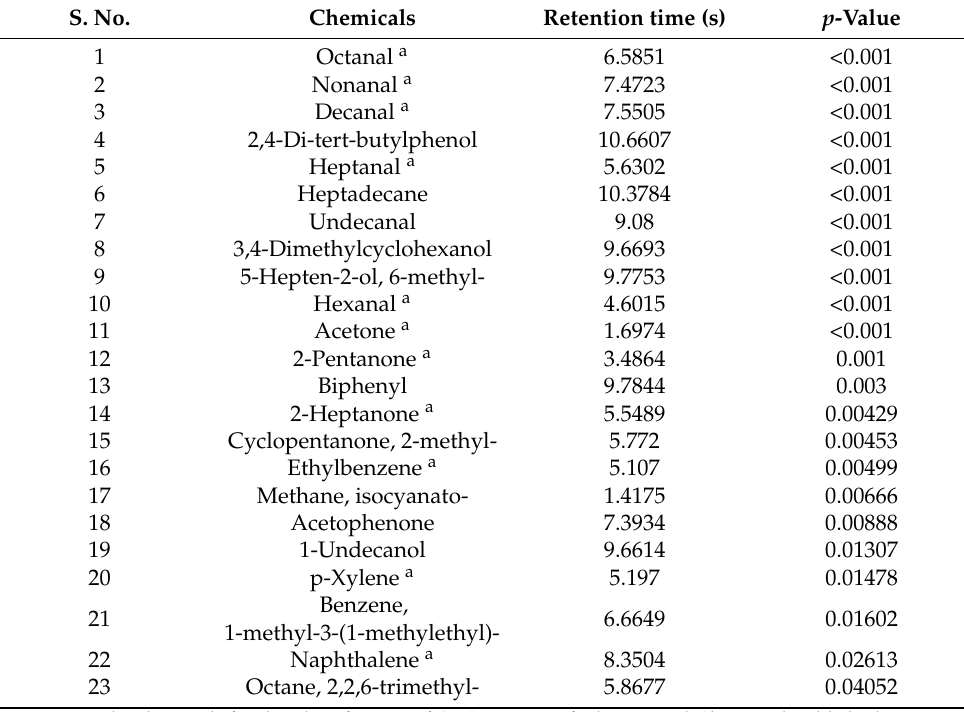
Table 5. VOCs obtained from GC-TOF-MS data analysis using the TOF-DS software. S. No.